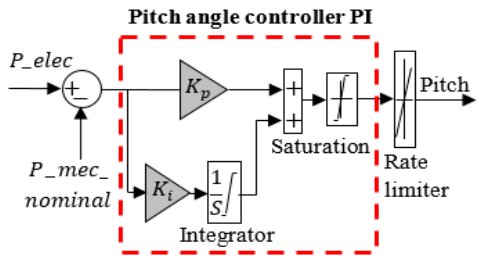
Figure 11. Curves of C power − γ for various pitch angles.